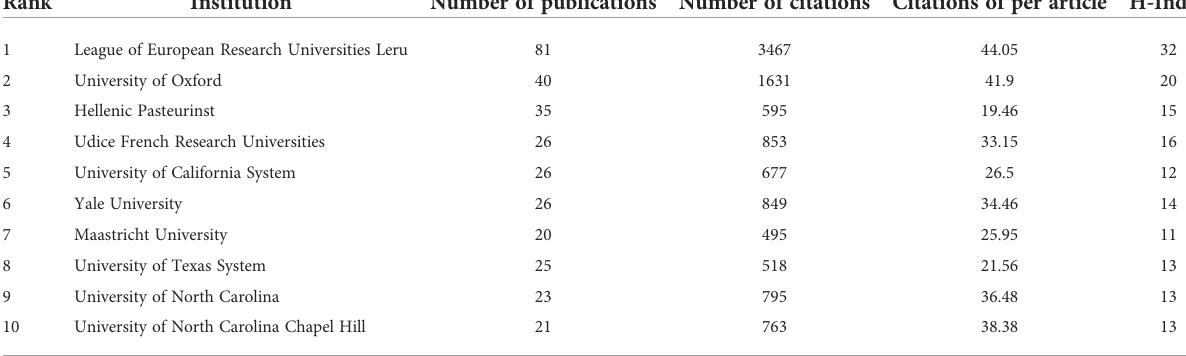
TABLE 2 The top 10 institutions with most publications in the fi eld of targeted immunotherapy for MG.